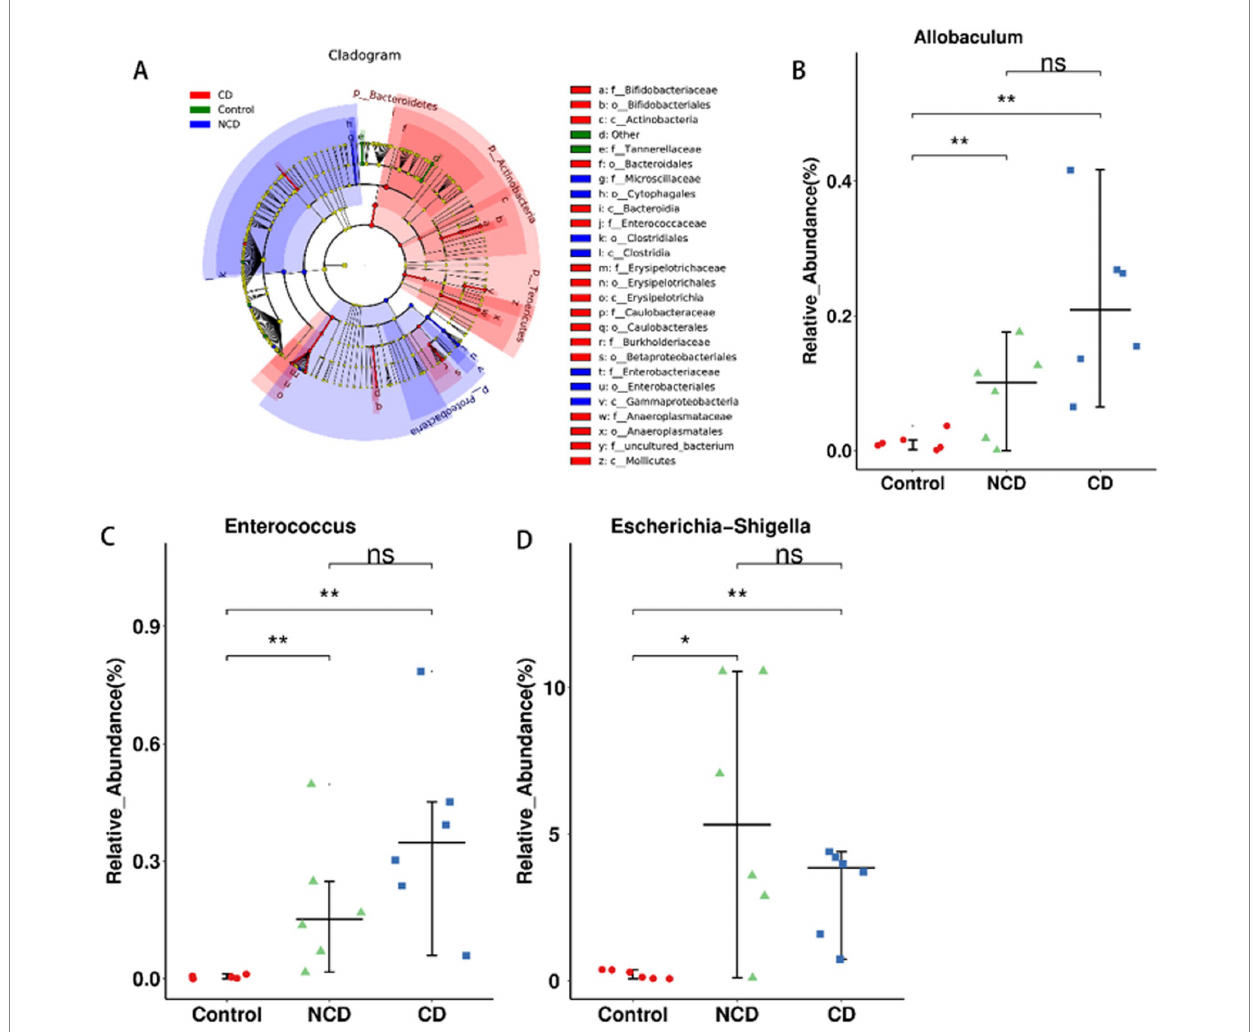
FIGURE 4 Differentially abundant bacterial taxa between the control and BDL mice. (A) LEfSe analysis among the three groups. LefSe, Linear discriminant analysis Effect Size. (B) Relative abundance of the phylum Allobaculum. (C) Relative abundance of the phylum Enterococcus. (D) Relative abundance of the phylum Escherichia-Shigella. Data are presented as the mean ± SEM. * p < 0.05, ** p